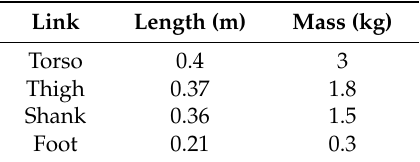
Table 1. The main physical parameters of the biped robot